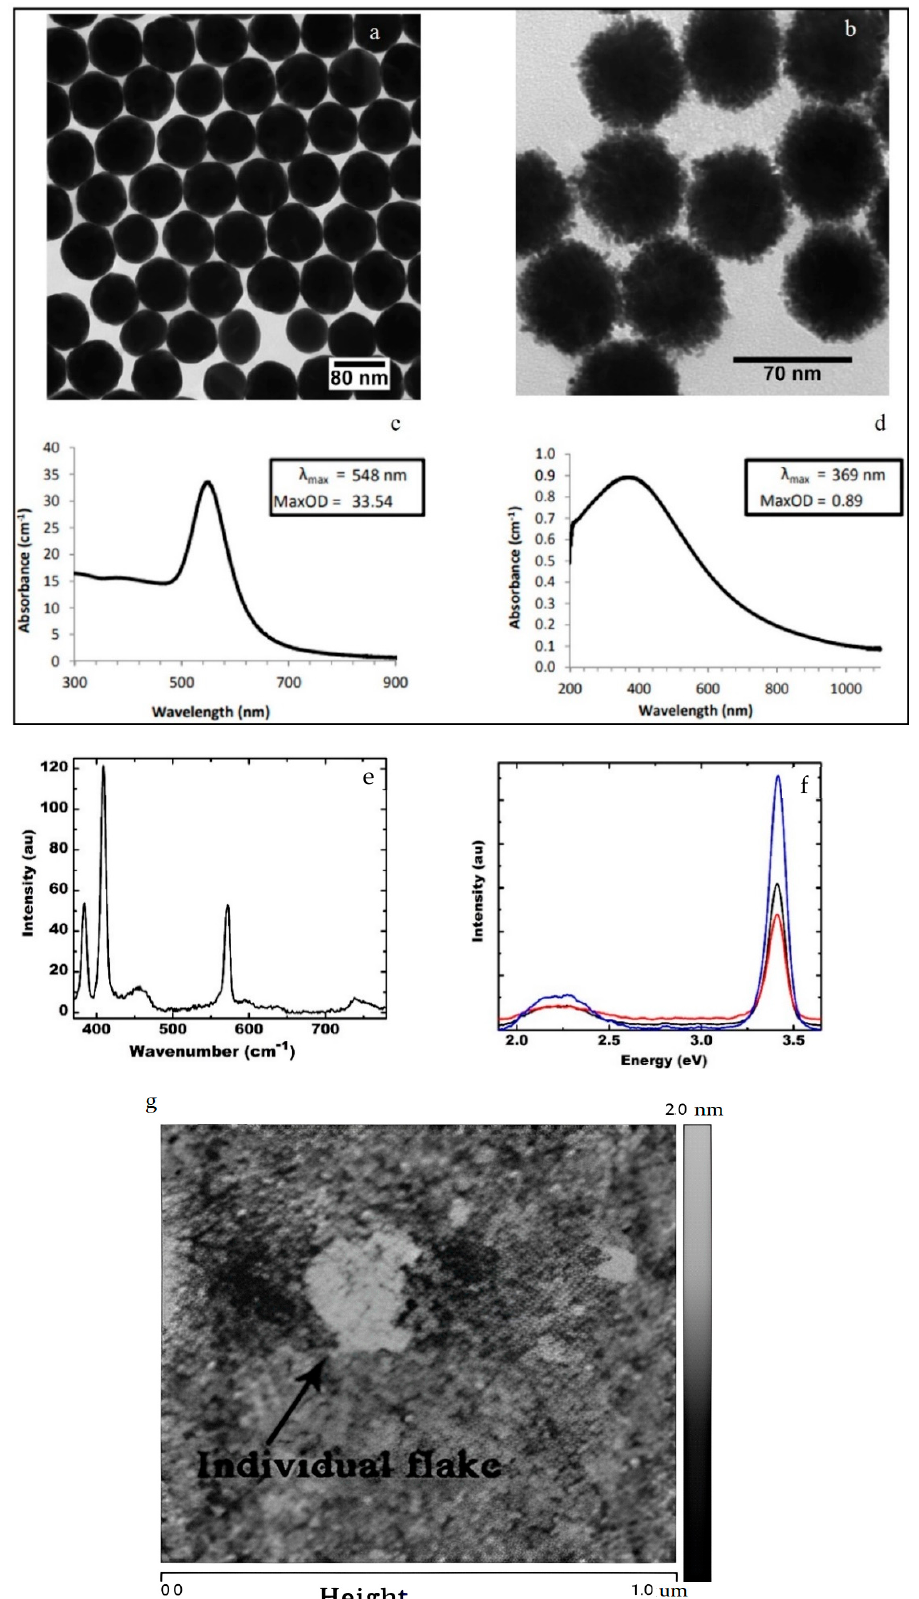
Figure 2. ( a ) SEM Images of Au NPs. ( b ) SEM images of Pt NPs. ( c ) The absorption spectrum of Au NPs. ( d ) The absorption spectrum of Pt NPs. ( e ) Raman characteristics show the active Raman